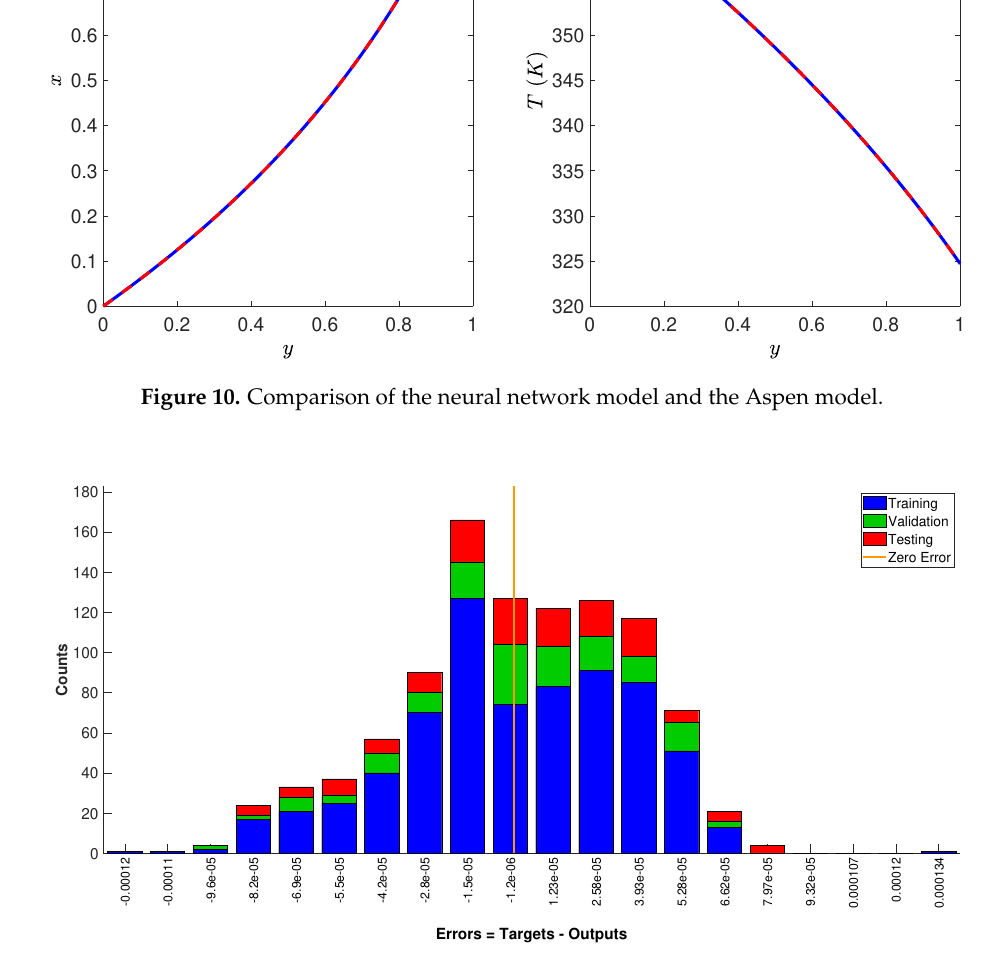
Figure 11. Error distribution histogram for training, validation, and testing